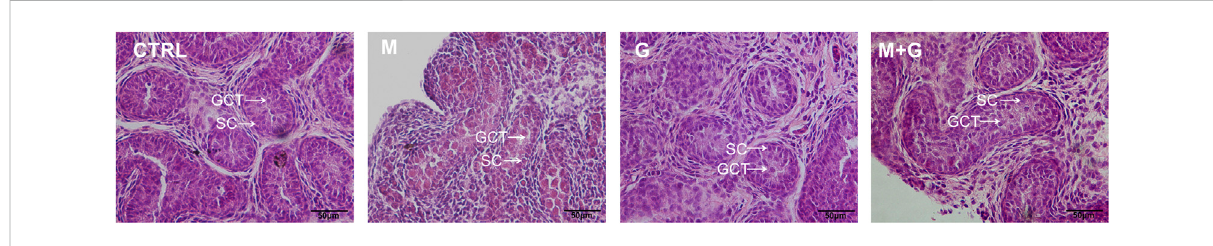
FIGURE 9 H&Estainingoffetaltestiscultured for4